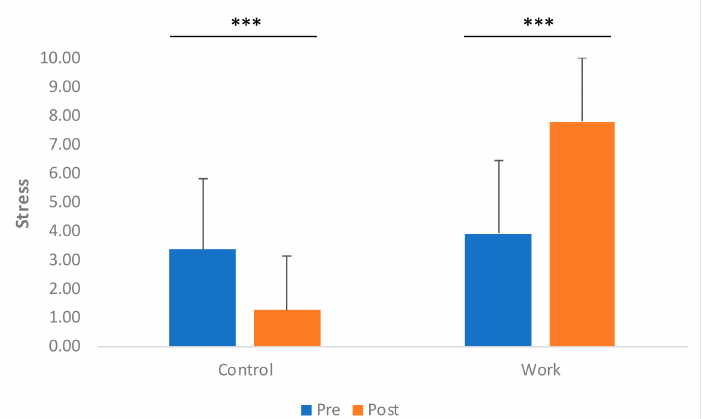
Figure 2. Self-rated stress for the control and work conditions. Pre- and post- significant di ff erences were observed at the ***: 0.1% level. Error bars represent the standard